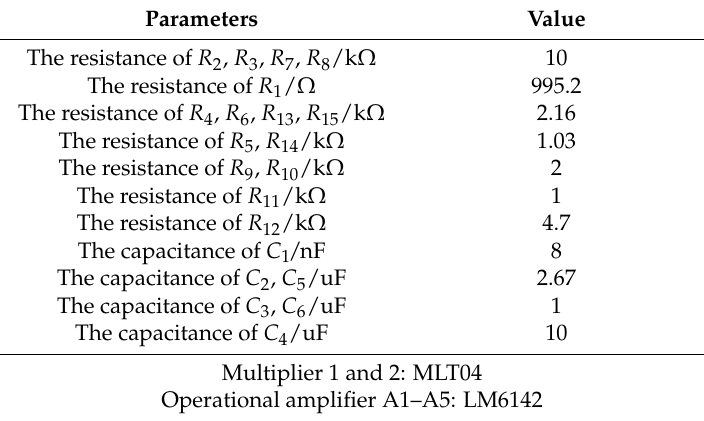
Table 1. Design specifications and parameters of the decomposition circuit.